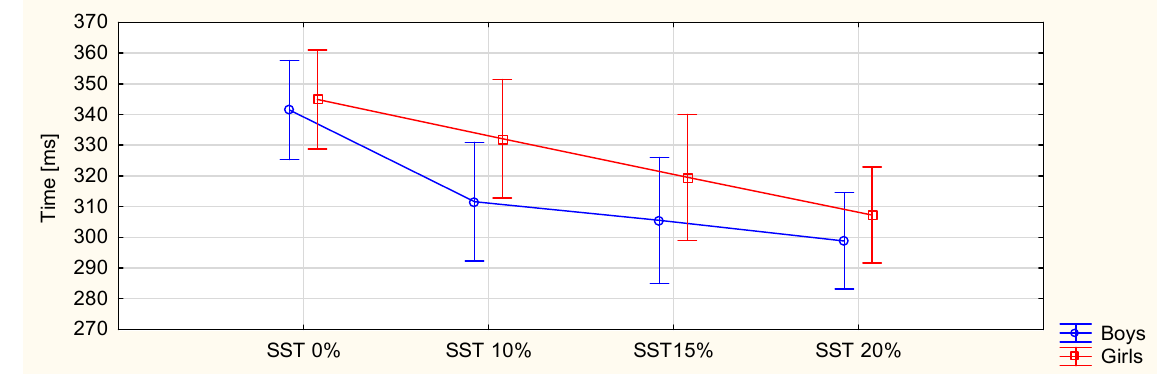
Figure 4. Single ‐ support ‐ time (SST) values for different BP loads. Figure 4. Single-support-time (SST) values for different BP loads.